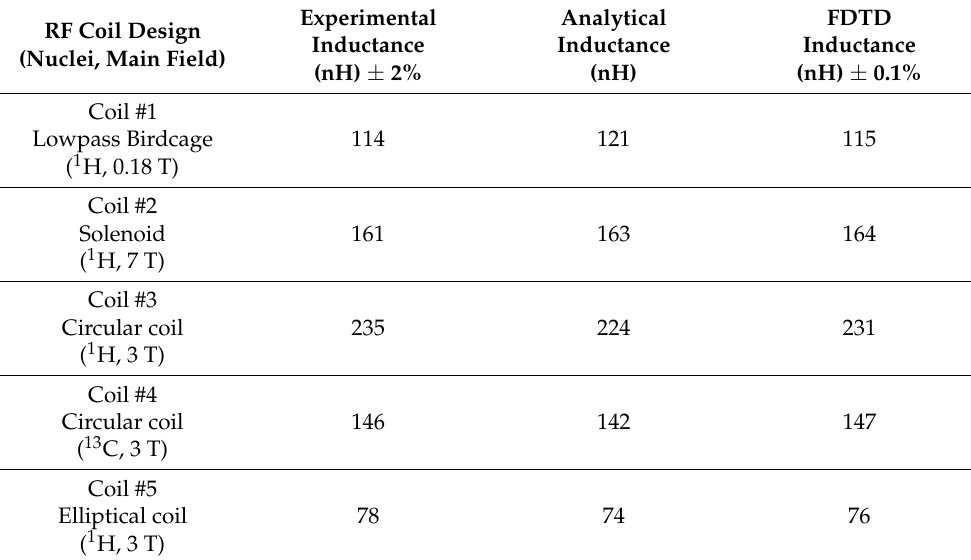
Table 1. Measured and simulated inductance for different RF